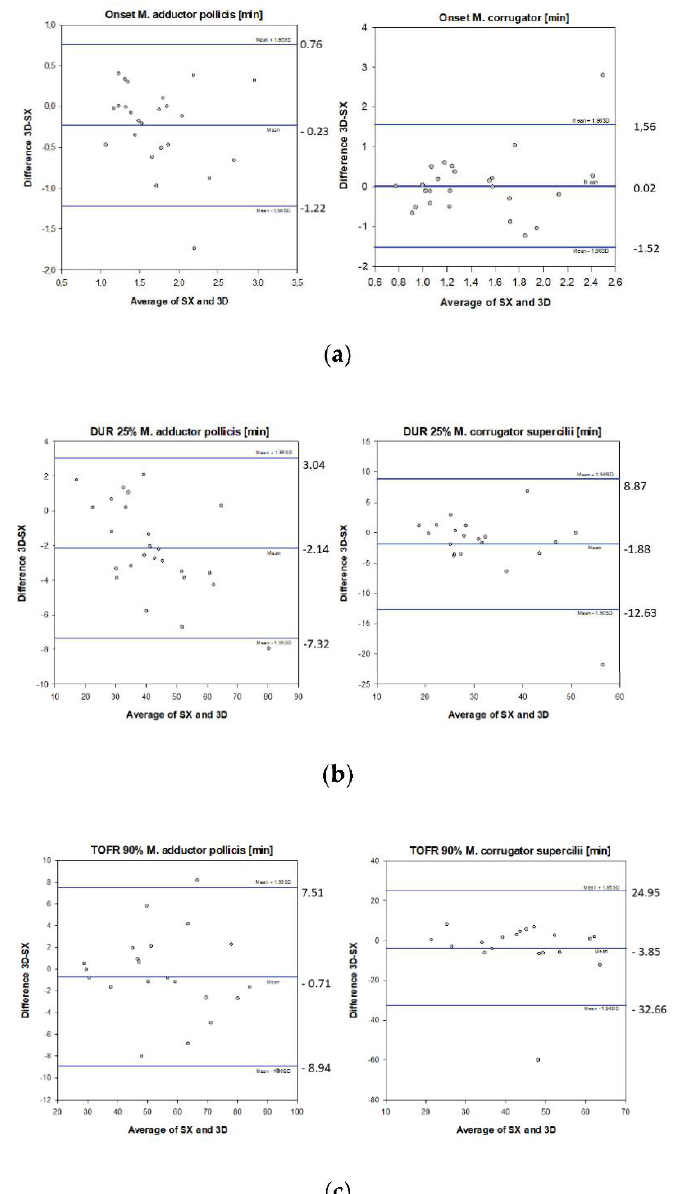
Figure 3. ( a – c ). Bland-Altman plots of the differences between TOF Watch SX and TOF 3D. Black horizontal line in the middle: bias; blue upper and lower line: limits of agreement ( ± 1.96 SD); ( a ) Onset: time (min) between the beginning of injection of rocuronium and maximum T 1 depression; ( b ) DUR25%: time (min) between administration of rocuronium and recovery to 25% twitch height; ( c ) TOFR 90%: time (min) from an injection of rocuronium to 90% train-of-four recovery. Time to 25% T 1 recovery (DUR 25%): In group A, recovery was faster when measured with the TOF 3D (bias: −2.14 min), with limits of agreement ranging from −7.32 to +3.04